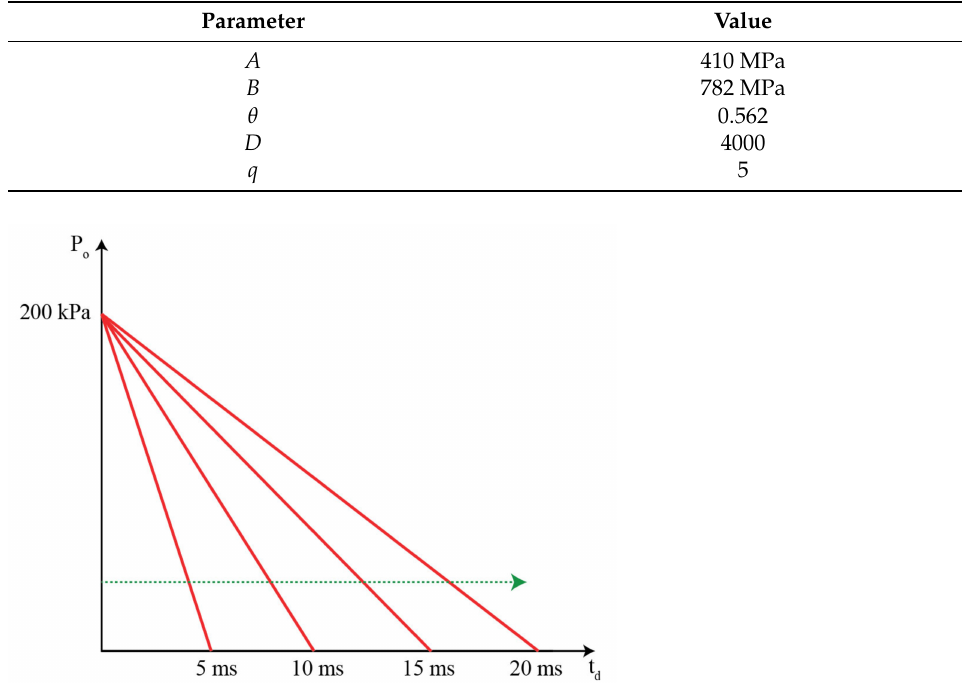
Table 1. Parameters values of the Johnson–Cook and the Cowper–Symonds models [29,30].